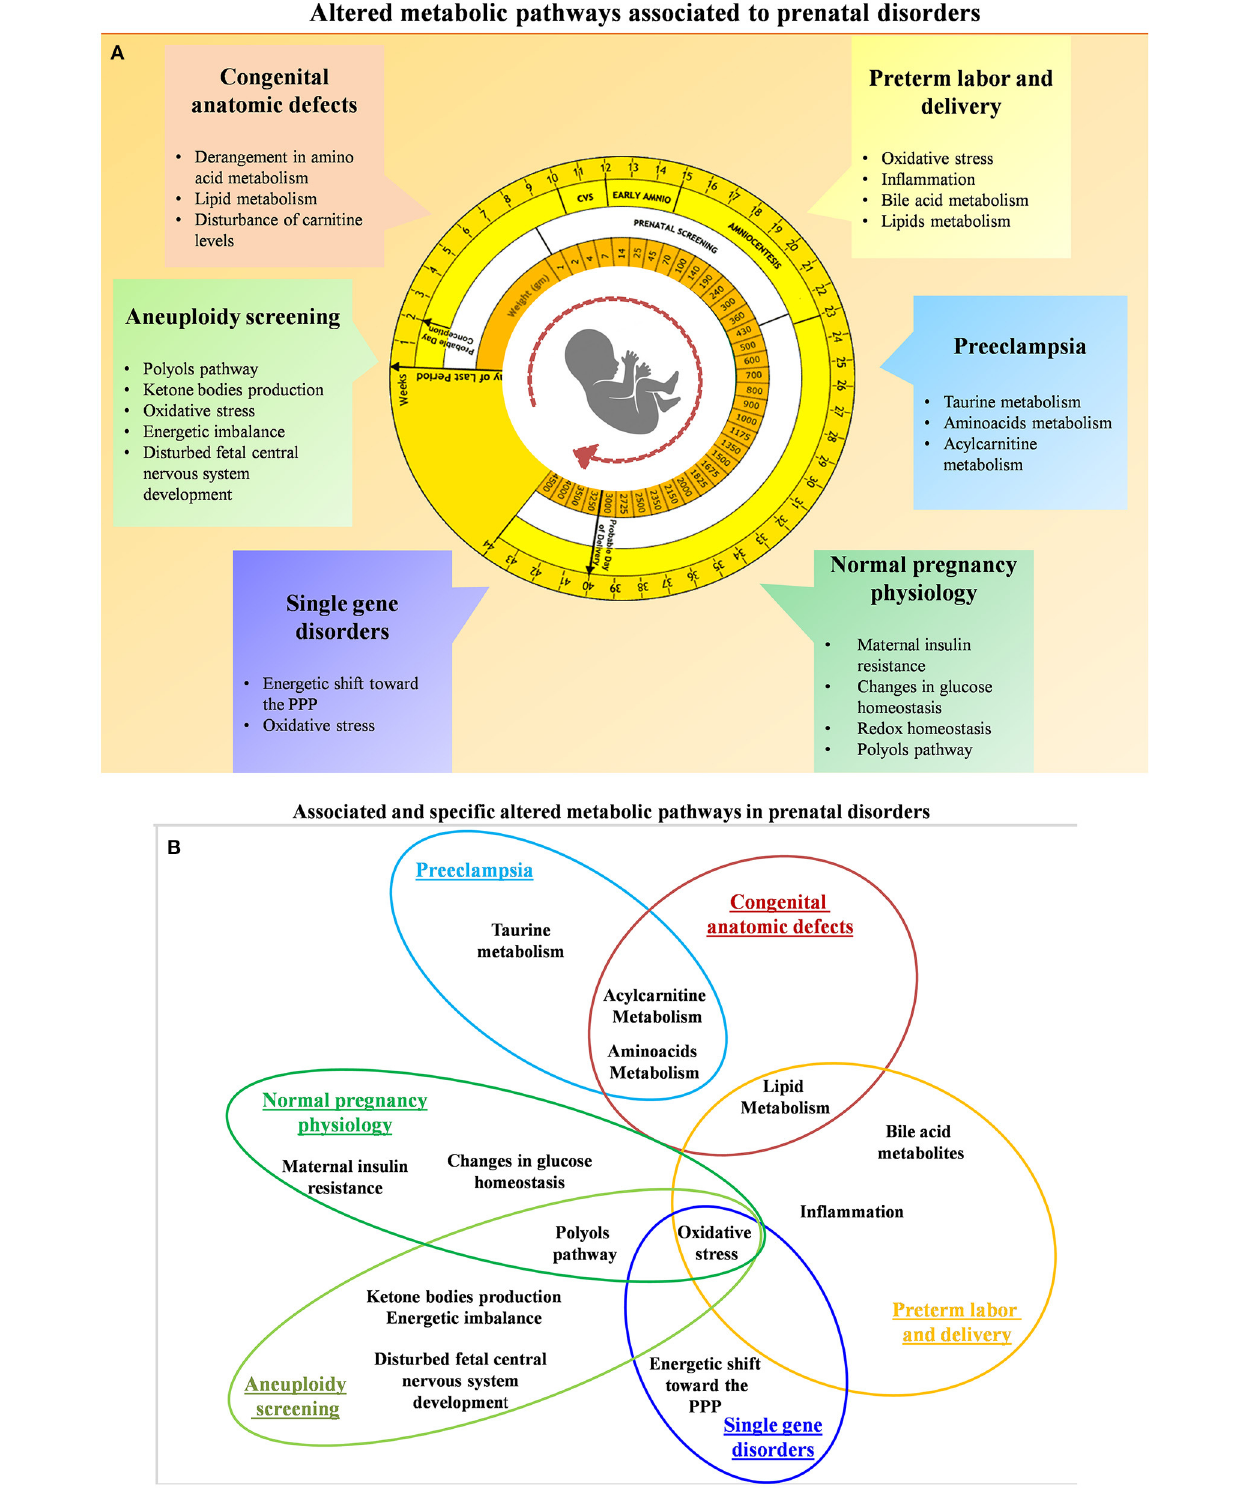
FIGURE 4 | (A) Summary of the altered metabolic pathways associated with prenatal disorders. (B) Associated and specific altered metabolic pathways in prenatal disorders.